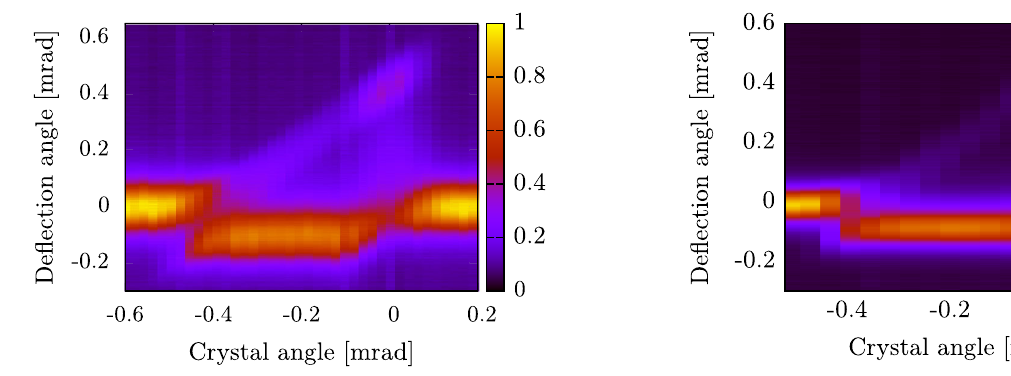
FIG. 6. The probability density relative to the maximum probability density of the deflected particles as a function of the crystal angle for the case of 6.3 GeV electrons.